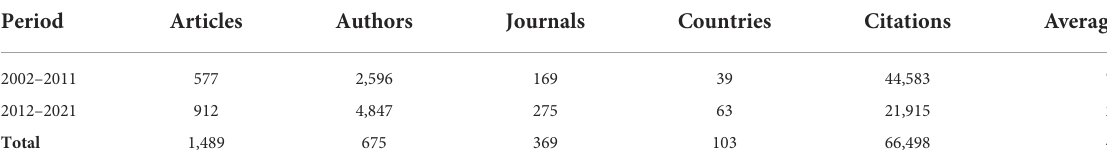
TABLE 2 Comparison of the major characteristics of the two periods (2002–2011 and 2012–2021).